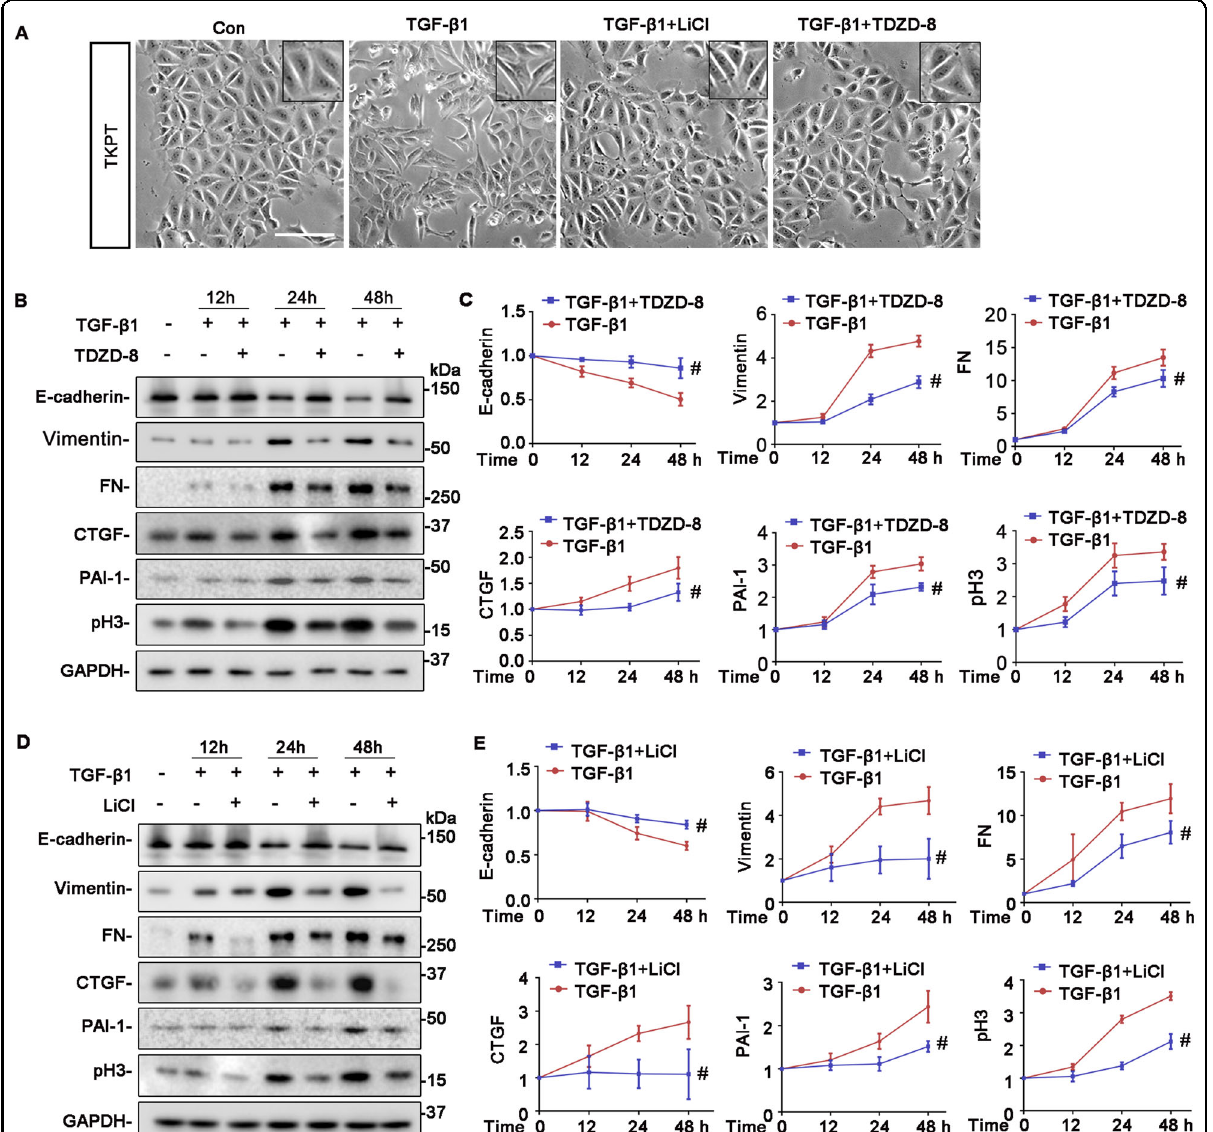
Fig. 3 The time course of the effects of TDZD-8 or LiCl on the TGF- β 1 induced TEC pro fi brogenic plasticity. A TKPT were treated with TGF- β 1 (2 ng/ml) for 24 h following pretreatment with TDZD-8 (10 μ mol/L) or LiCl (10 mmol/L) for 30 min. Representative phase-contrast micrographs were shown. Scale bar = 100 μ m. B TKPT were treated with TGF- β 1(2 ng/ml) for 12 h, 24 h, 48 h following pretreatment with TDZD-8 (10 μ mol/L) or ( D ) LiCl (10 mmol/L) for 30 min. Cell lysates were prepared for immunoblot analysis for E-cadherin, vimentin, FN, PAI-1, CTGF, pH3, and GAPDH. Representative immunoblots were shown. C , E Densitometric analyses of the expression of E-cadherin, vimentin, FN, PAI-1, CTGF, and pH3, as normalized to the expression of GAPDH and expressed as fold changes relative to the control group based on immunoblot analysis. # P < 0.05 versus TGF- β 1 group ( n = 3, t